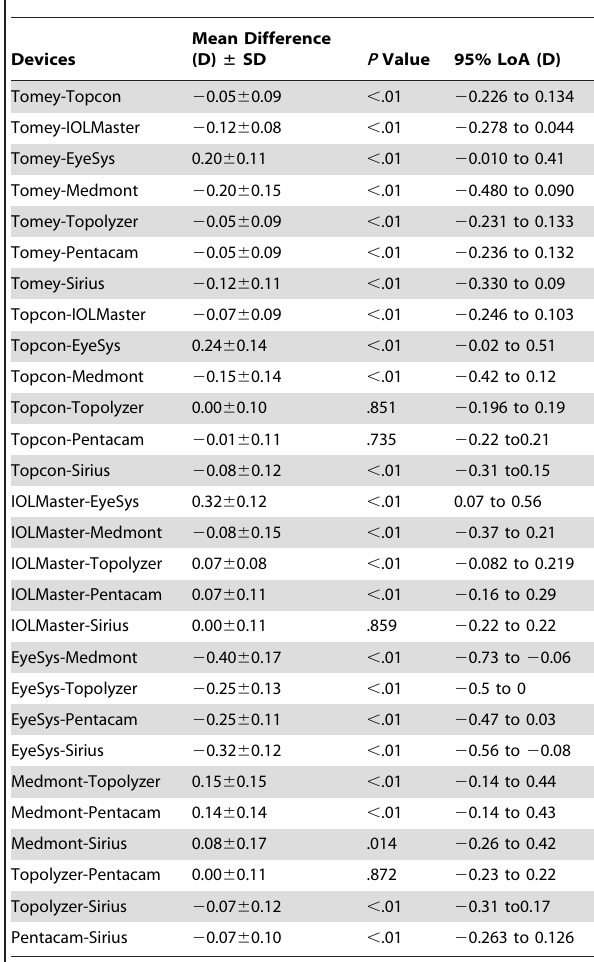
D=diopter, SD=standard deviation, LoA=limits of agreement.